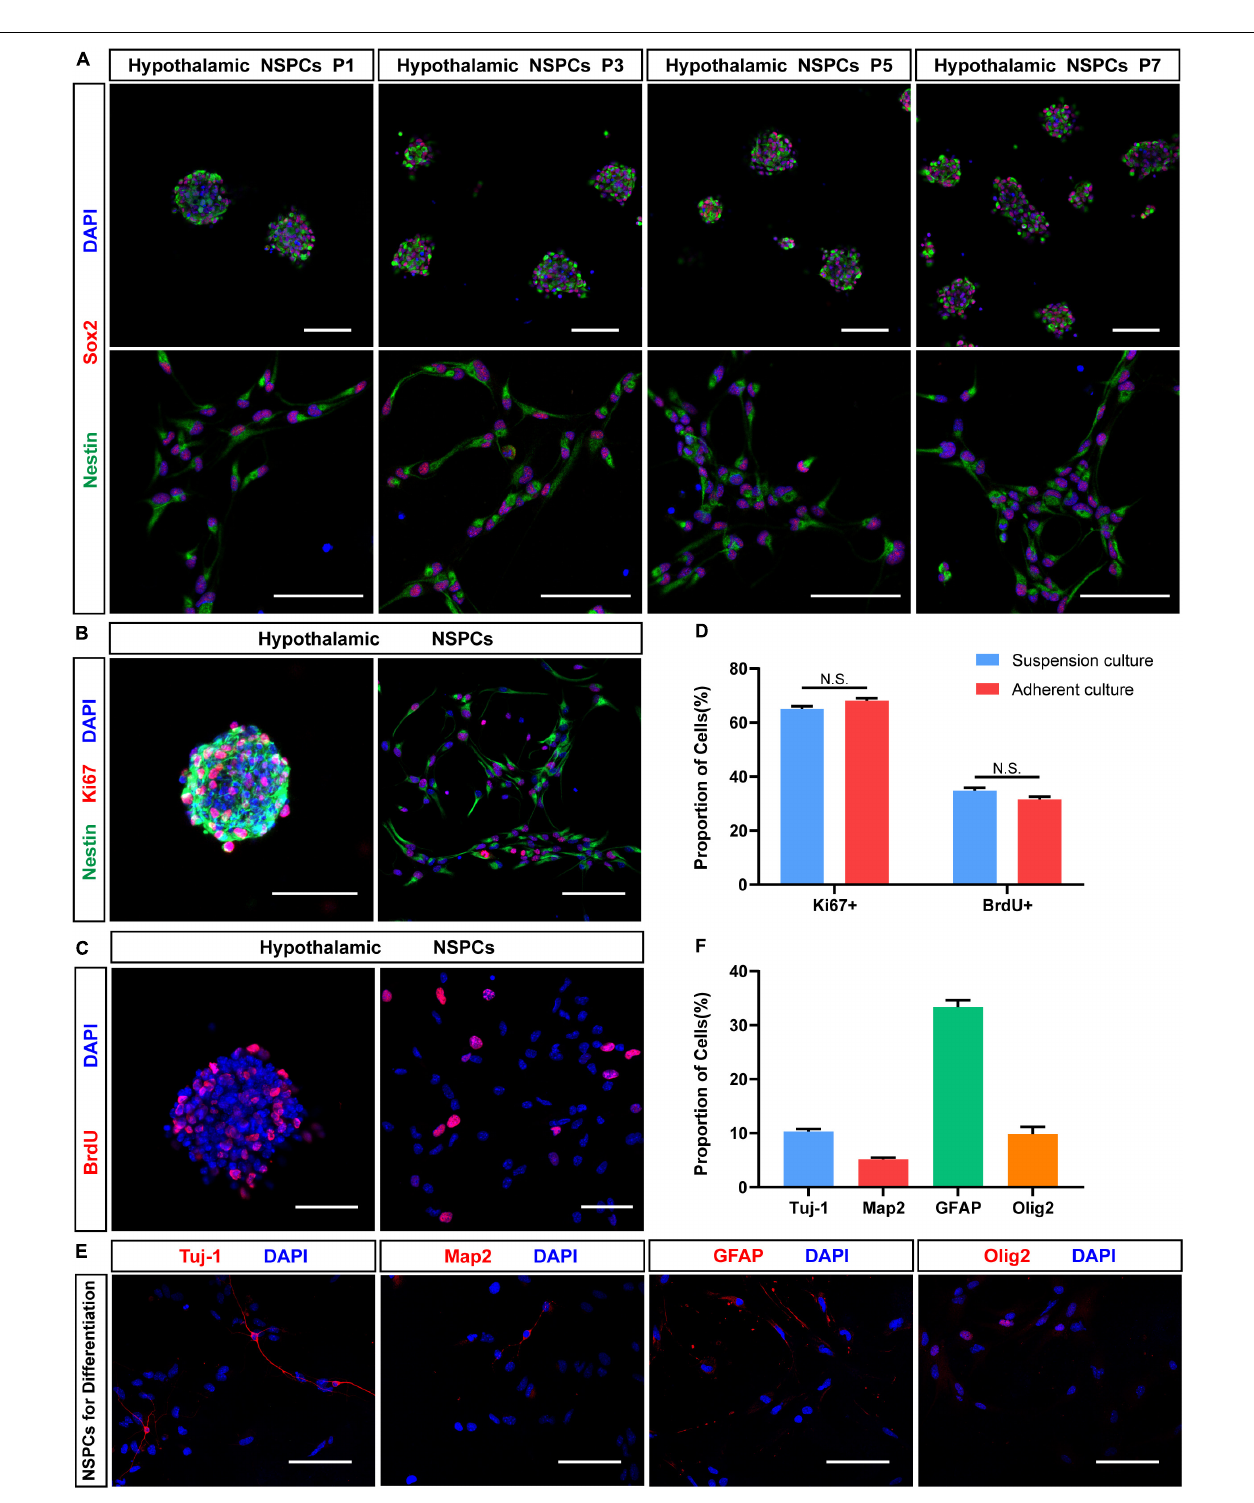
FIGURE 4 | Proliferation and neuronal differentiation assay in hypothalamic NSPCs. (A) Immunostaining for Sox2 (red) and Nestin (green) of hypothalamic NSPCs in different passage (P1, P3, P5, P7). Scale bar: 75 µ m. (B) Immunostaining for Nestin (green) and Ki67 (red) of P3–5 hypothalamic NSPCs. Scale bar: 100 µ m. (C) Immunostaining for BrdU (red) after 6 h of BrdU incorporation of P3–5 hypothalamic NSPCs. Scale bar: 50 µ m. (D) The percentage of Ki67 and BrdU immune-positive cells in (B,C) ( n = 6 in each group; not significant by two-tailed Student’s t -test). (E) Immunostaining for Tuj-1, Map2, GFAP, and Olig2 of P3–6 hypothalamic NSPCs after 5–7 days differentiation. Scale bar: 100 µ m. (F) The relative percentage of immunopositive cells in (E) ( n = 6 in each group).